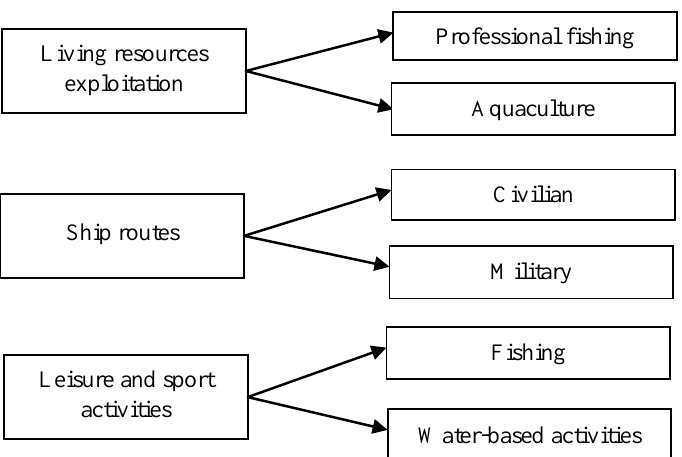
Figure 5. Sea activities (adapted from